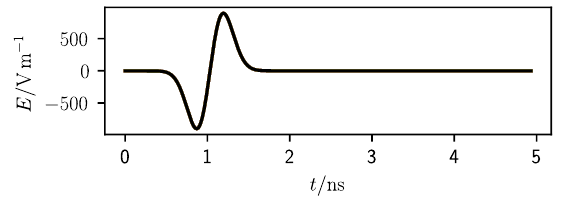
Figure 3. Averaged waveform for a 3 cm deep target at 1 GHz central frequency and a 3 × 3 antenna